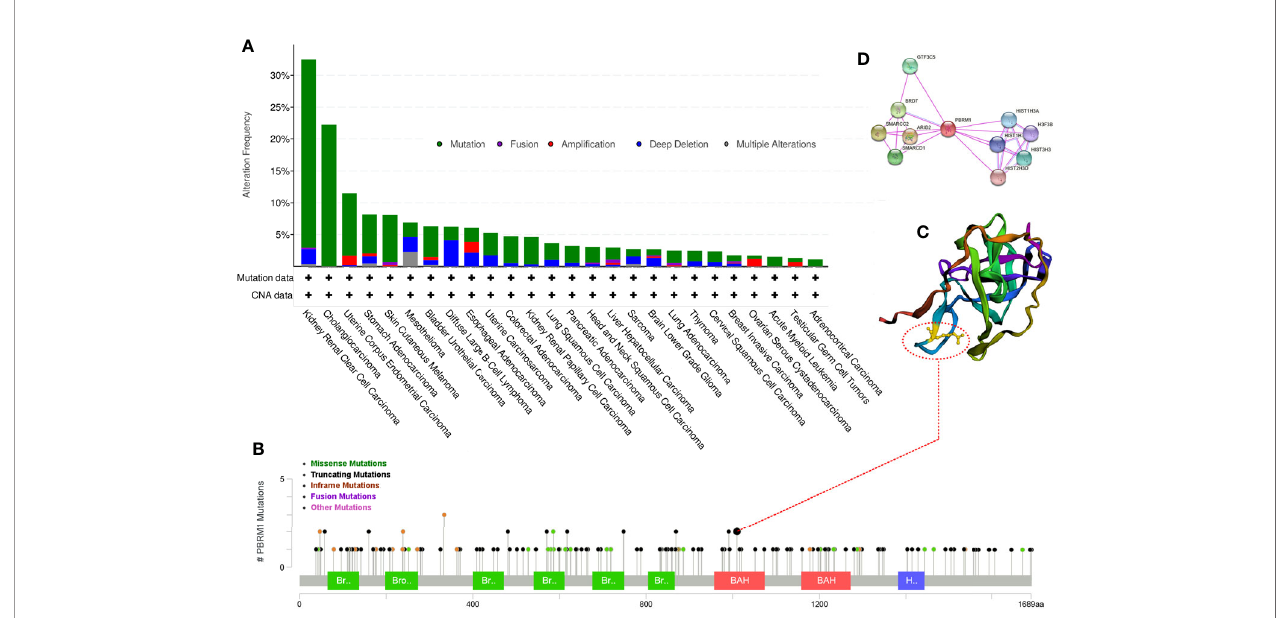
FIGURE 2 | Mutation frequency of PBRM1 in tumors reproduced from the Cancer Genome Atlas (TCGA) database. (A) Alternation frequency of PBRM1 in various tumors are shown. (B) Mutation types of PBRM1 in ccRCC are shown. (C) 3D structure of PBRM1 and the mutation cite is shown. (D) Protein-protein interaction network of PBRM1 are shown. The top 10 experimentally determined genes ranked by degree are